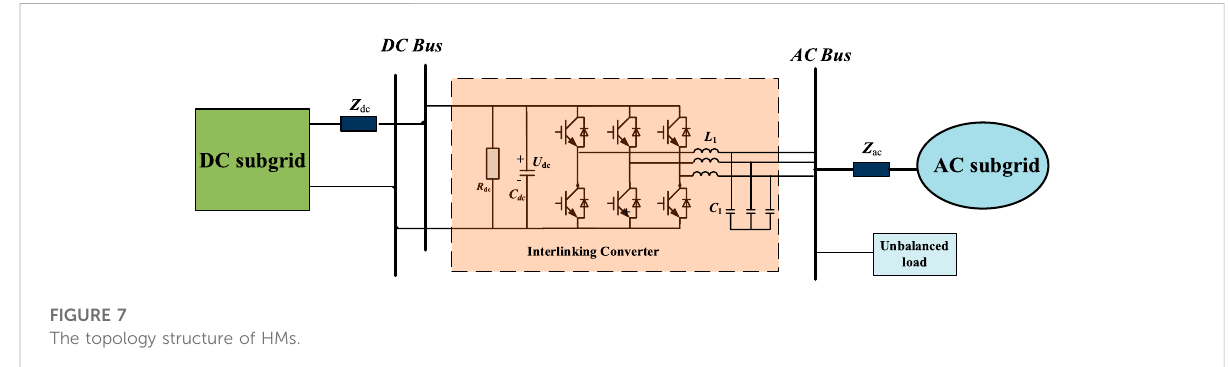
FIGURE 7 The topology structure of HMs.